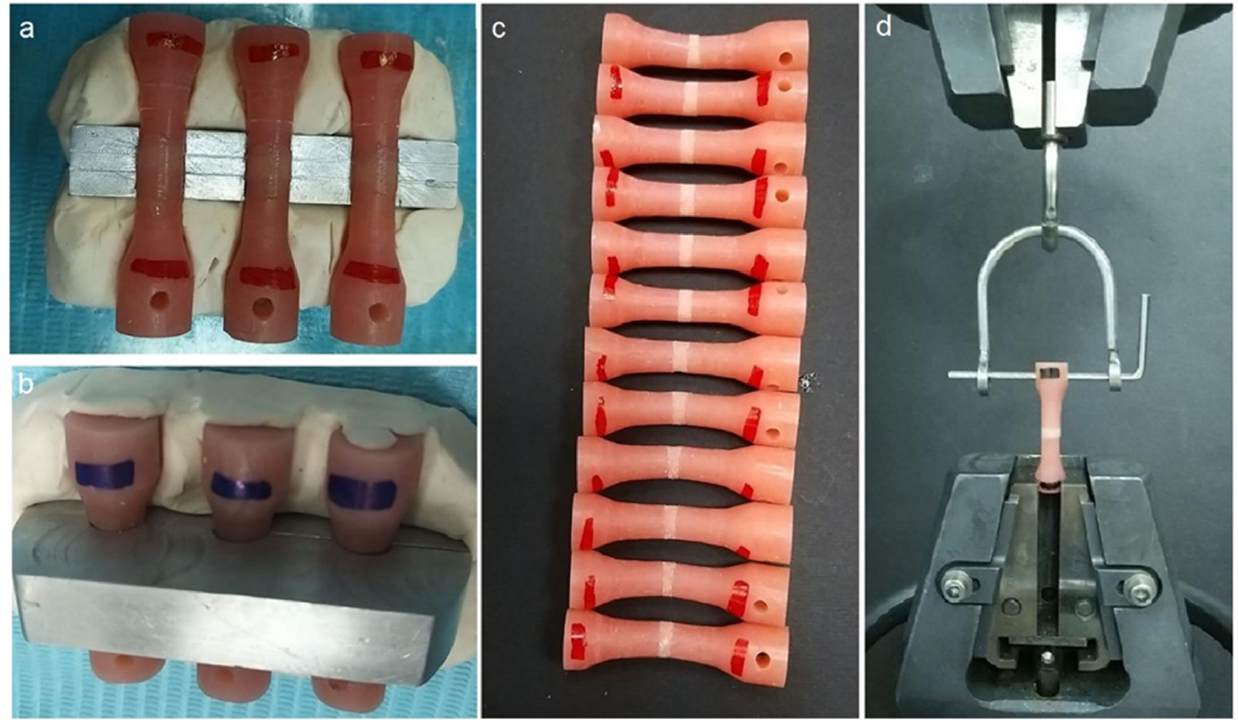
Figure 2. Specimen preparation and bond strength testing. ( a ) Specimen placed in the customized mold before soft liner application, ( b ) COE-SOFT liner allowed to polymerize in the mold, ( c ) completed specimen before thermal cycling, and ( d ) specimen placed in the jig of universal testing machine.